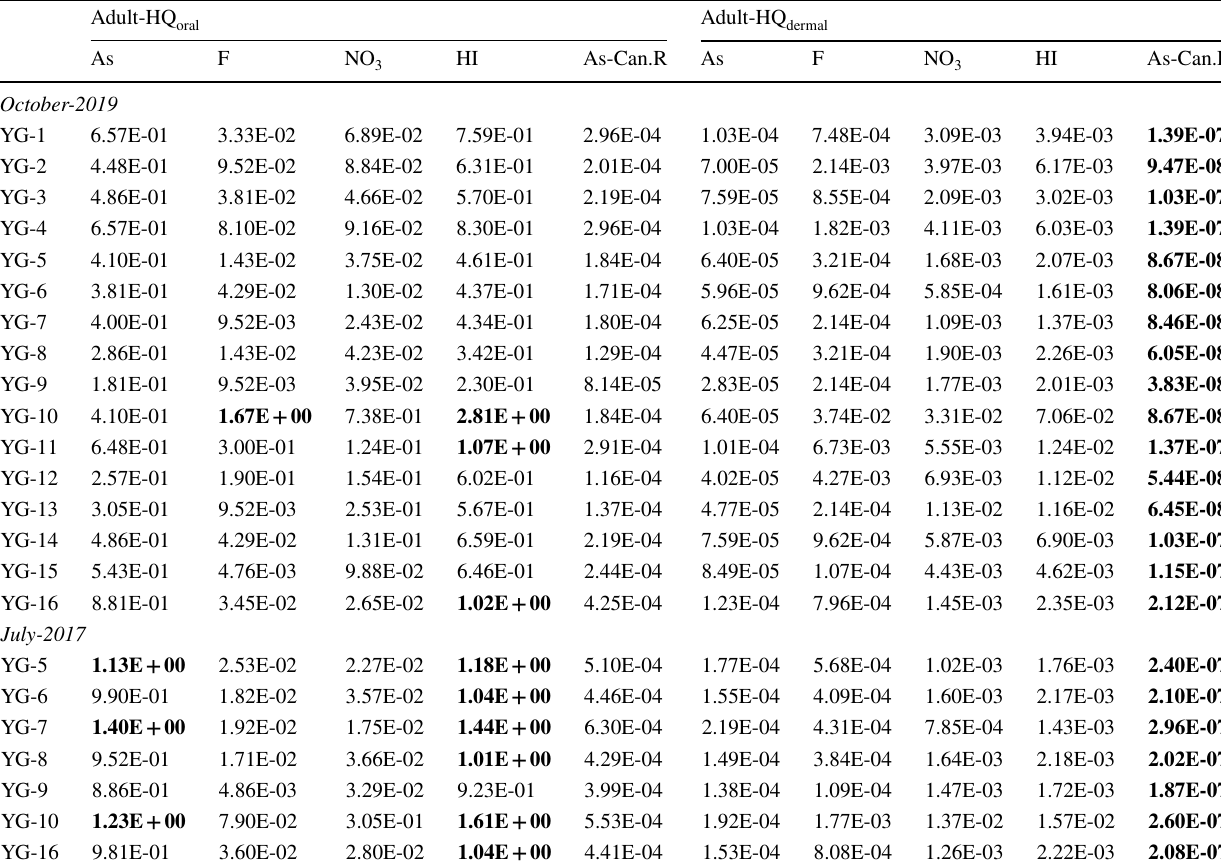
Boldface are the values that exceed the limit